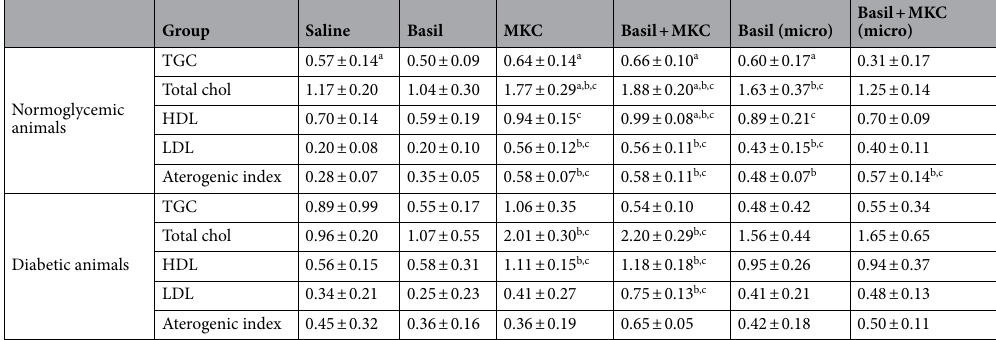
Table 3. The levels of triglycerides, total cholesterol, HDL and LDL cholesterol (mmol/l, x ± SD) and serum index of atherosclerosis in normoglycemic and diabetic animals. a p < 0.05 in relation to basil + MKC (micro). b p < 0.05 in relation to the group saline. c p < 0.05 in relation to the group